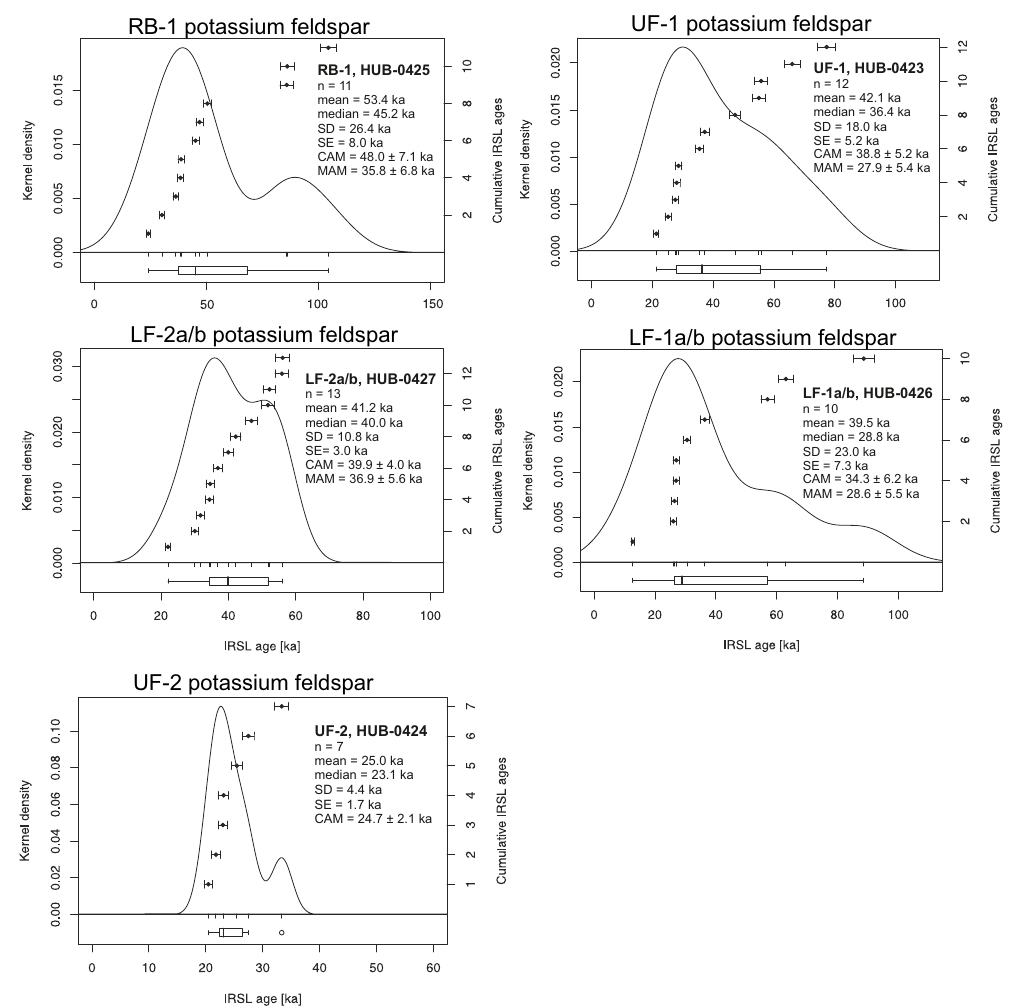
Figure 7. Individual IRSL ages for all selected aliquots and resulting kernel density estimates. Mean: arithmetic mean; SD: standard devia- tion; SE: standard error; CAM: Central Age Model; MAM: Minimum Age Model. The box plots, below the main graph, describe the dose distribution as follows: median as bold line, box delimited by the first and third quartiles, and whiskers defined by the extremes within 1.5 interquartile